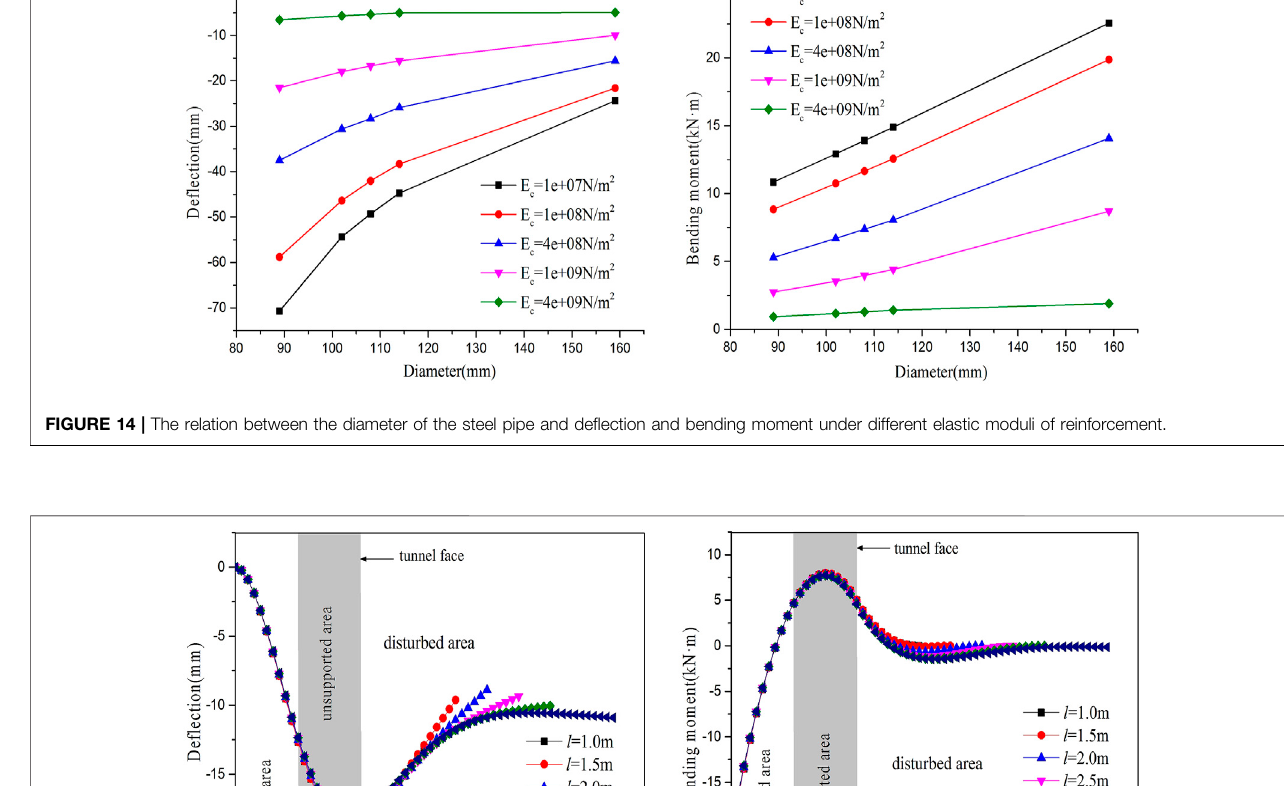
tunnel excavation footage and the de fl ection and bending moment curves of the pipe-roof under different diameters are drawn, as shown in Figure 13 .